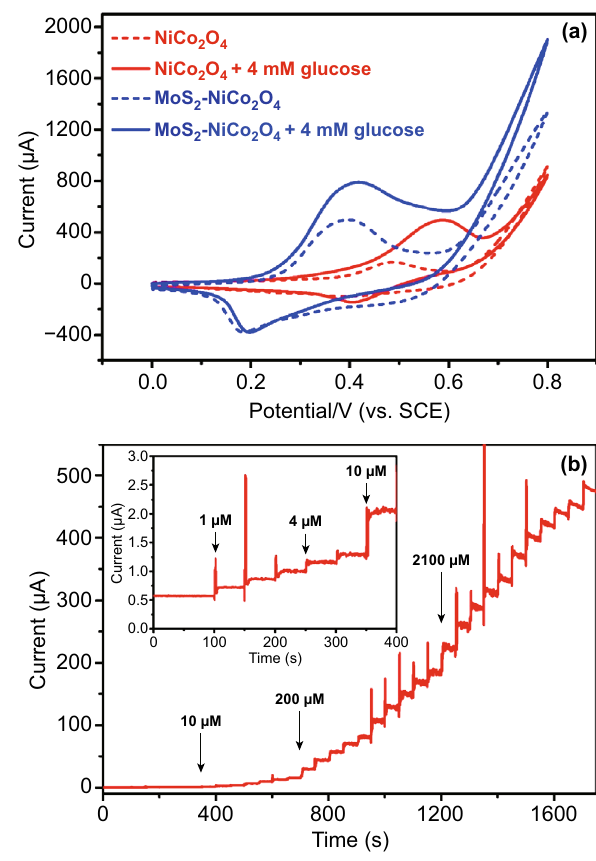
Fig. 23 a Nyquist plots of NiCo 2 O 4 , Co 3 O 4 , and NiO-modified GCE in 0.1 M NaOH. b CV curves for NiCo 2 O 4 , Co 3 O 4 , and NiO-modified GCE in 0.2 M NaOH without glucose. Reproduced with permission from Ref. [140]. Copyright © 2016 Elsevier B.V.